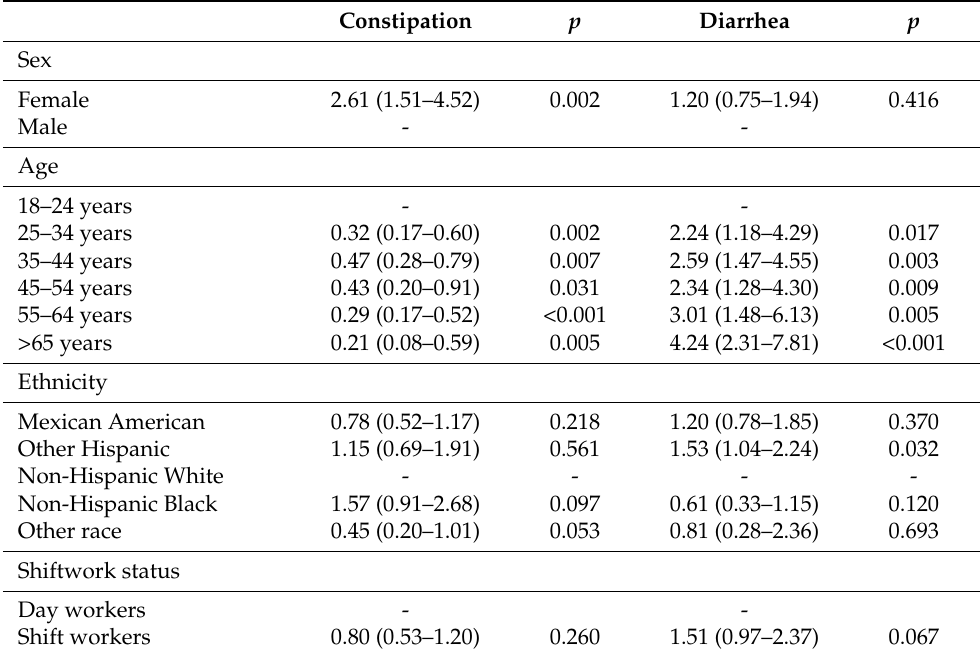
Table 5 legend: OR are displayed with their 95% confidence intervals and p -value. The symbol “-” indicates the reference category. p = p